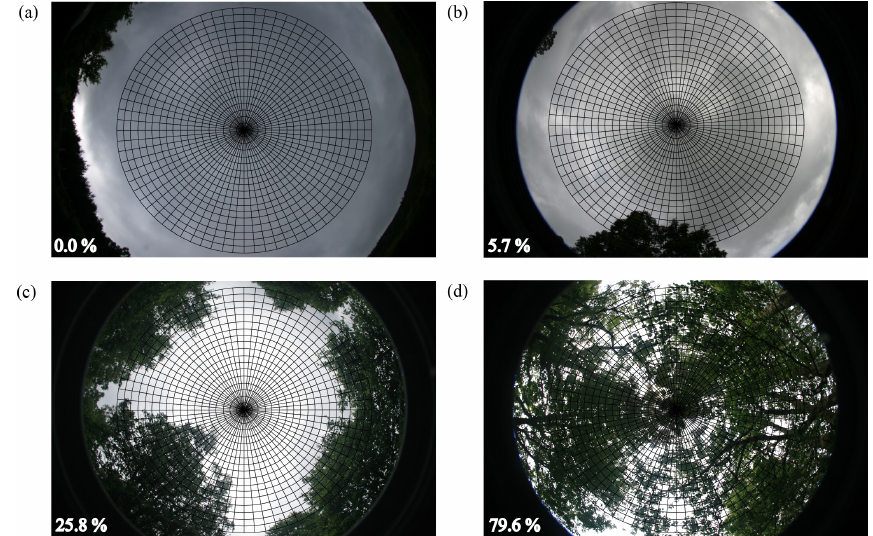
Figure 5. Hemispherical photographs representative of (a) clear-sky view, (b) low-density, patchy riparian forest, (c) low-density, continuous riparian forest and (d) high-density, continuous riparian forest. The grid represents the 5 ◦ azimuth and zenith overlay applied by Gap Light Analyzer